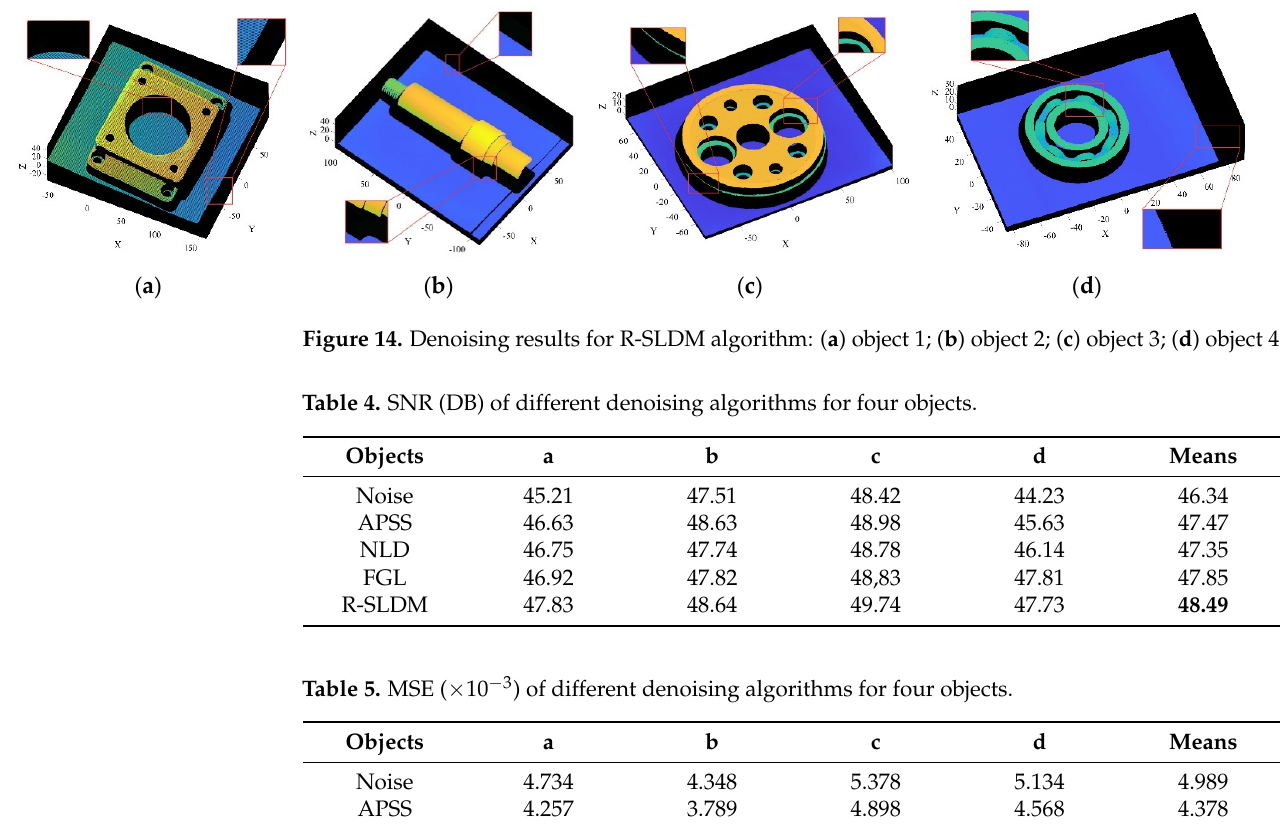
Figure 13. Denoising results for FGL algorithm: ( a ) object 1; ( b ) object 2; ( c ) object 3; ( d ) object 4.